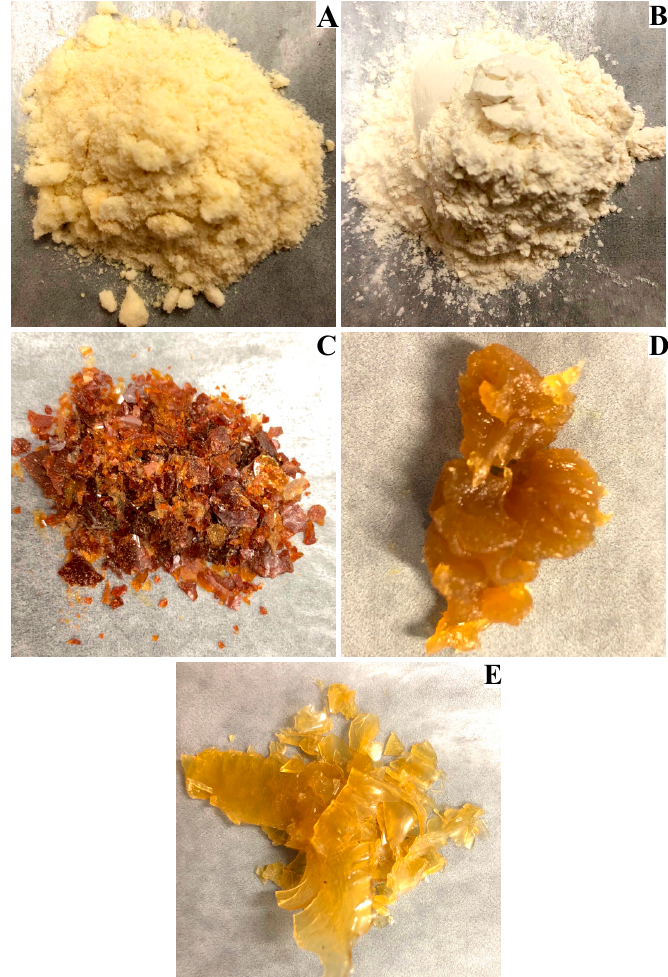
Figure 2. Aquafaba samples prepared by different drying methods: ( A ) freeze drying; ( B ) spray